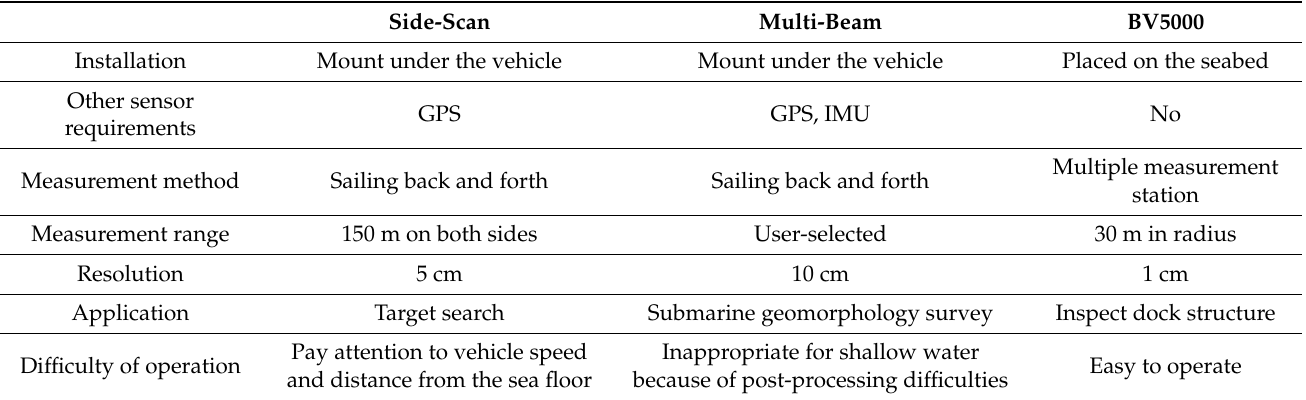
Table 1. Comparison of the three sonar types.